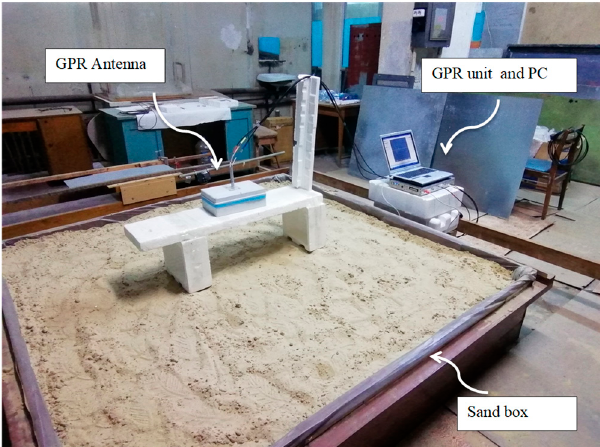
Figure A1. Laboratory sand test bed. In this photo, the antenna system rests on foam blocks above the sand surface. The control system is to the right of the test bed.